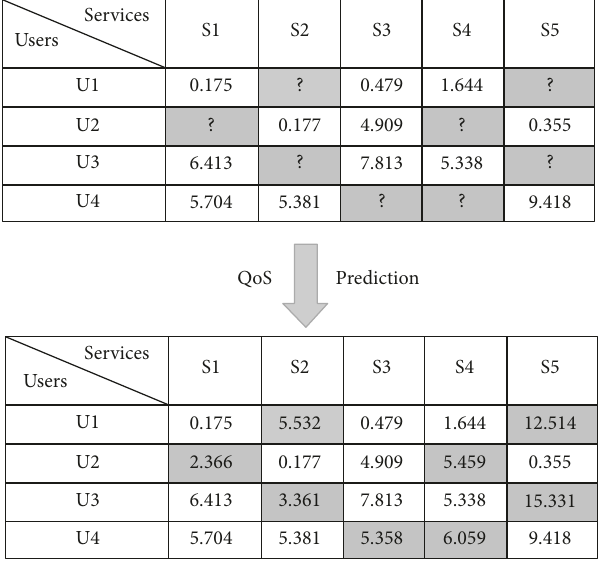
Figure 1: An example of QoS